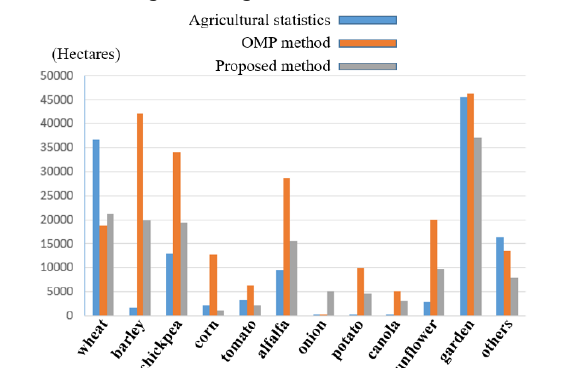
Figure (4). Comparison of the estimated agricultural products with ground